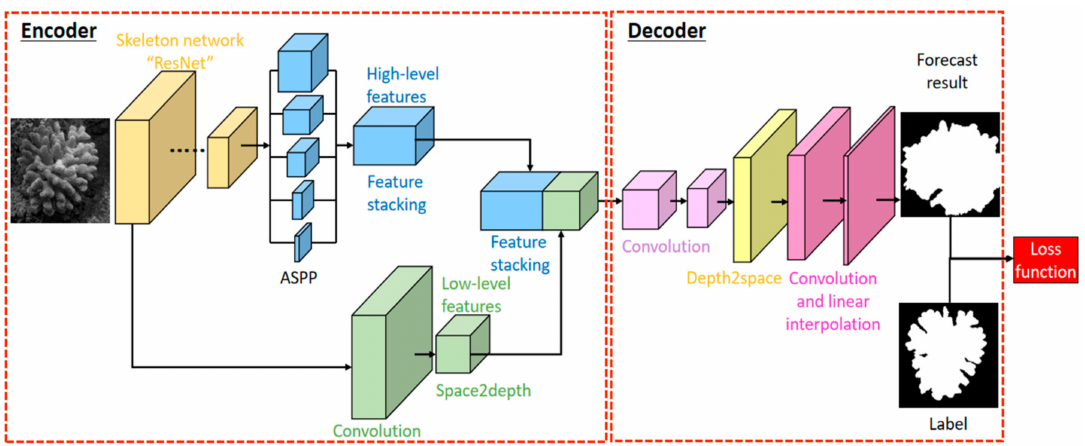
Figure 1. Structure of the DeeperLabC model for coral semantic